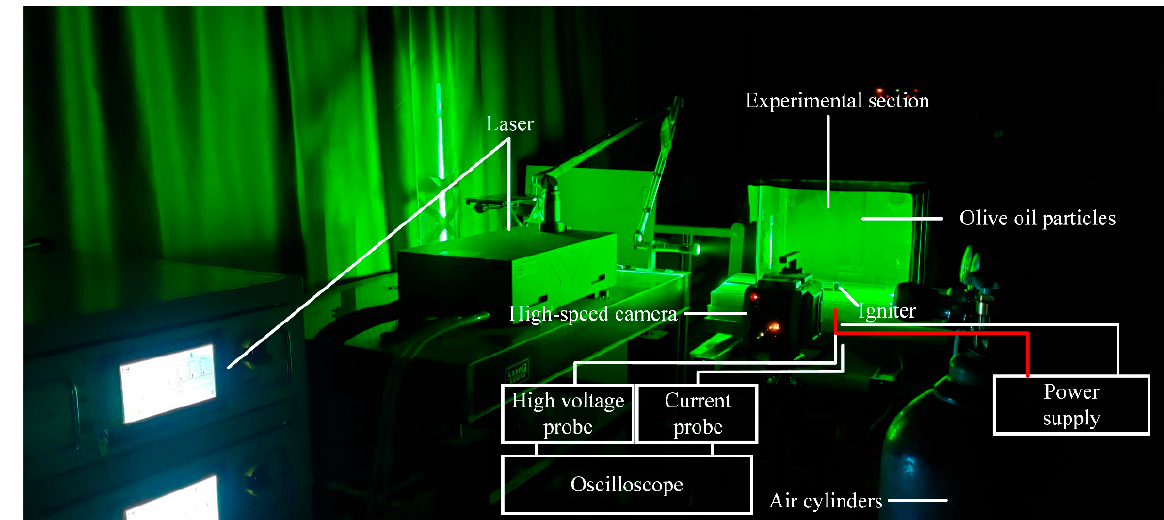
Figure 2. Characteristic experimental system.